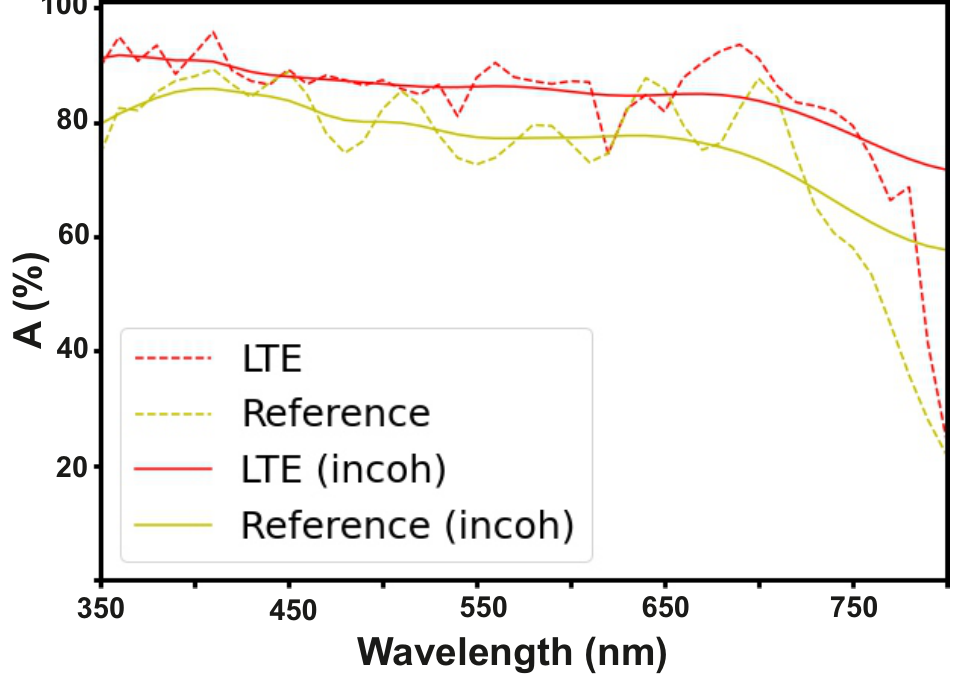
Figure 5. Incoherent illumination: Spectral absorption in active layer (calculated for λ = 350–800 nm). According to the calculations, the parameter “Gain” did not change significantly for PSCs when they were illuminated by coherent and incoherent light, and therefore, for our structure, it is acceptable to use the coherent